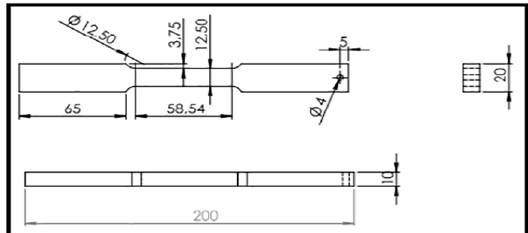
Figure 2. Schematic diagram of the coupon used in the tensile test.